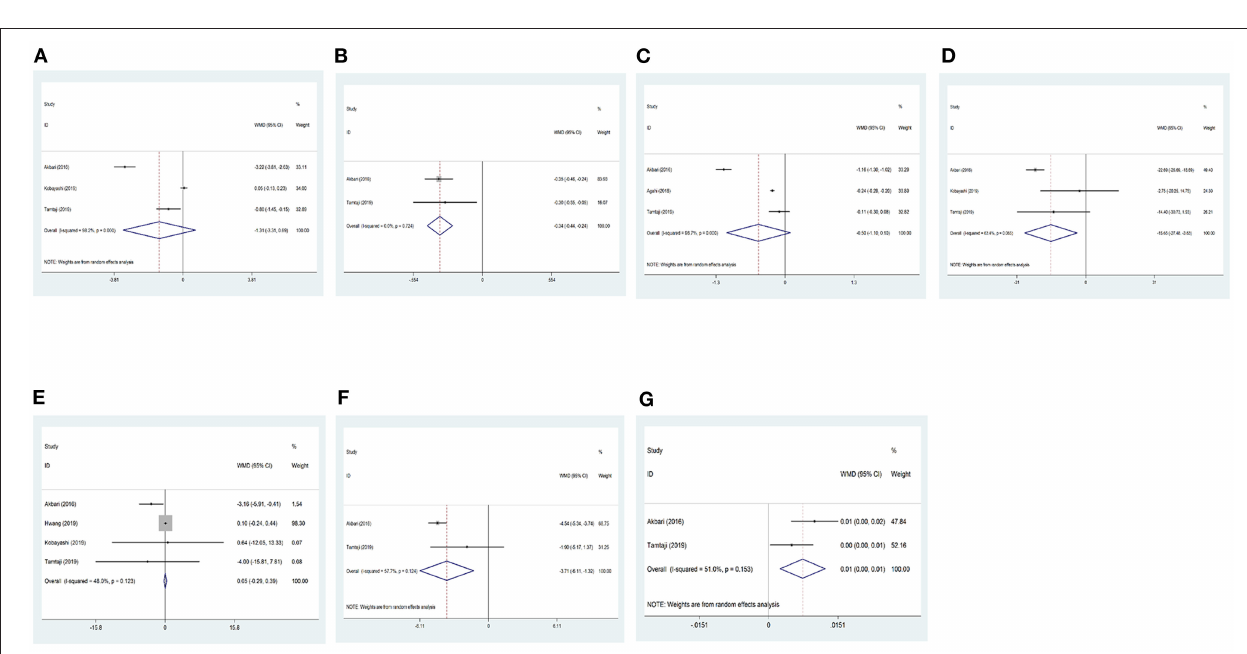
FIGURE 4 | Forest plots showing the effect of probiotic administration on the level of clinical biomarkers. (A) hs-CRP; (B) HOMA-IR; (C) MDA; (D) triglycerides; (E) total cholesterol; (F) VLDL; and (G)